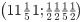
Analytical pairwise comparison of i(A)CG strategies.For each pair of strategies the maps show if the first of the two strategies increases in frequency (up-arrow), or decreases (down-arrow) depending on visibility of the other player’s action and the already existing fraction of the respective strategy. The red lines mark the invasion thresholds, i.e. the minimal fraction of the first strategy necessary for taking over the population against the competitor second strategy. Solid-line invasion thresholds show the stable equilibrium fraction which allows coexistence of both strategies (see “Methods”). Dashed-line invasion thresholds indicate dividing lines above which only the first, below only the second strategy will survive. In all strategies, 1 stands for 0.999 and 0—for 0.001, the entries s9 = … = s12 = 1 are the same for all strategies and are omitted. (A) Turn-taker (q01q; 0000) with q = 5/8 for psee > 0 outperforms Aggressive Challenger (11151;12121512), (B) but not Challenger (910101;1212012). (C) Challenger can coexist with Aggressive Challenger for low transparency, but is dominated for psee > 1/3. (D) Leader-Follower (1111; 0000) clearly outperforms Turn-taker for psee > 0.4 and (E,F) other strategies for psee > 1/3.